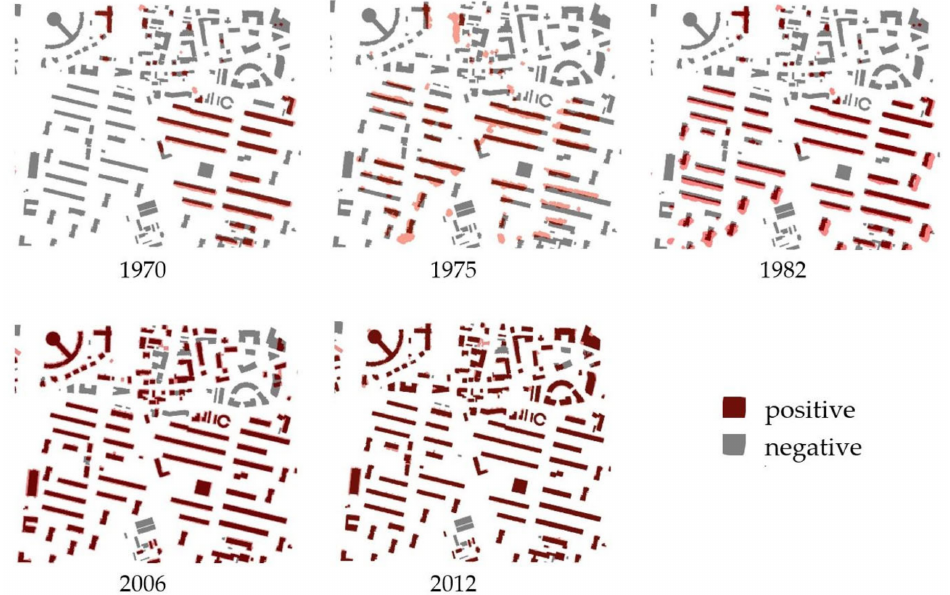
Figure 11. Detected buildings for each